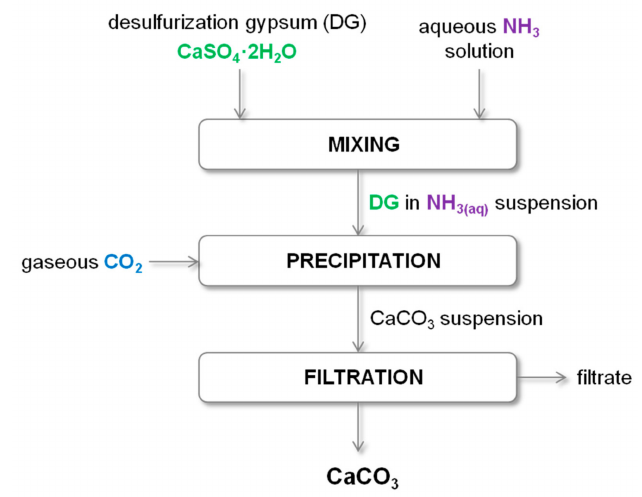
Figure 7. Diagram of the CaCO 3 precipitation process by direct carbonation of desulfurization gypsum.